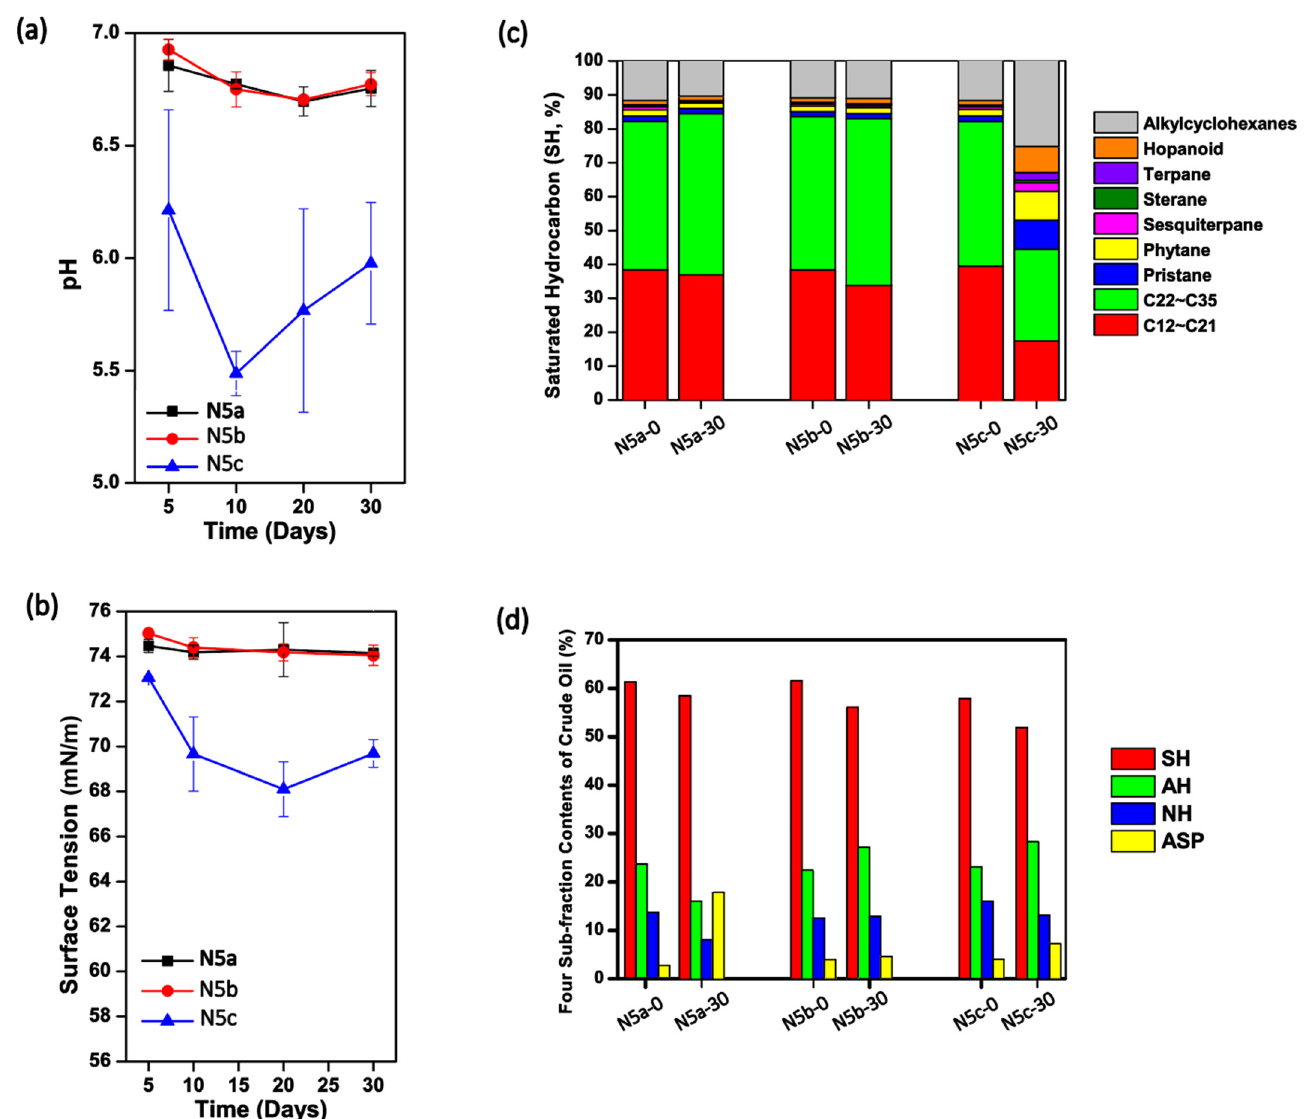
Figure 1. The physicochemical characteristics changes of solutions containing crude oil being pretreated with different frequencies of heating. The time courses of pH values ( a ) and surface tension degrees ( b ) in solutions containing one-time heated (N5a), two-time heated (N5b), and raw (N5c) crude oil; Comparison of the saturated hydrocarbon components ( c ) and the four-subfraction contents ( d ) in the crude oil samples collected from Treatments N5a, N5b, and N5c at the beginning and end of the 30-day incubation. SH, saturated hydrocarbon; AH, aromatic hydrocarbon; NH, non-hydrocarbons; ASP, asphaltenes.